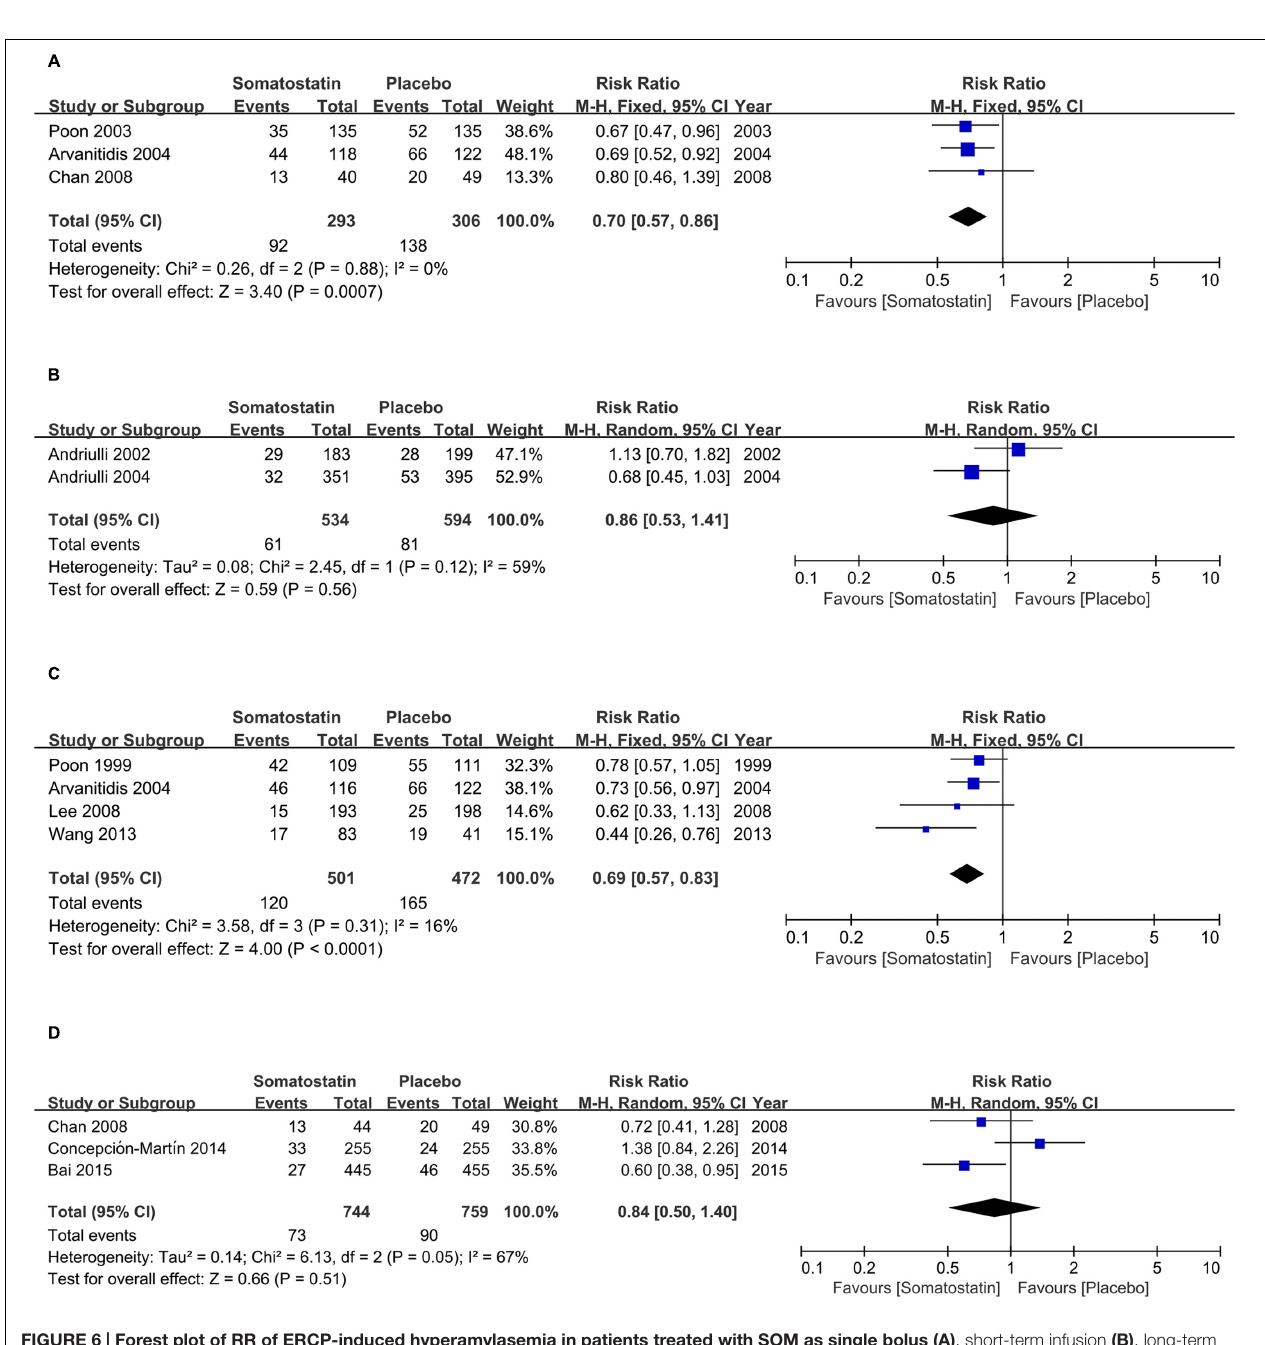
injury after ERCP could be prevented with the administration of SOM with an OR of 0.38 (95% CI: 0.22, 0.65; P < 0.001). abdominal pain (OR = 0.65, 95% CI: 0.48, 0.90; P =